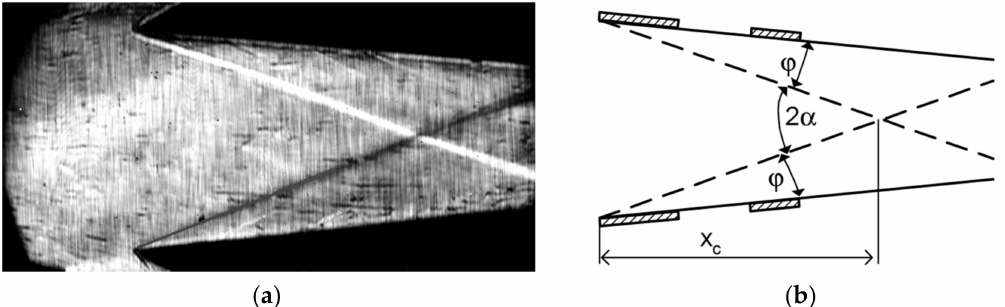
Figure 4. ( a ) Schlieren picture of attached shocks; ( b ) Scheme of the location of the shocks with indication of the measured